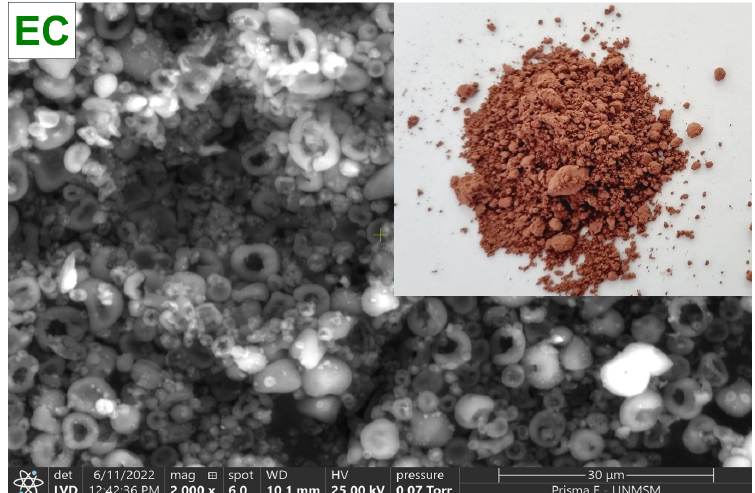
Figure 2. Erythrocytes of Cavia porcellus spray-dried (EC).